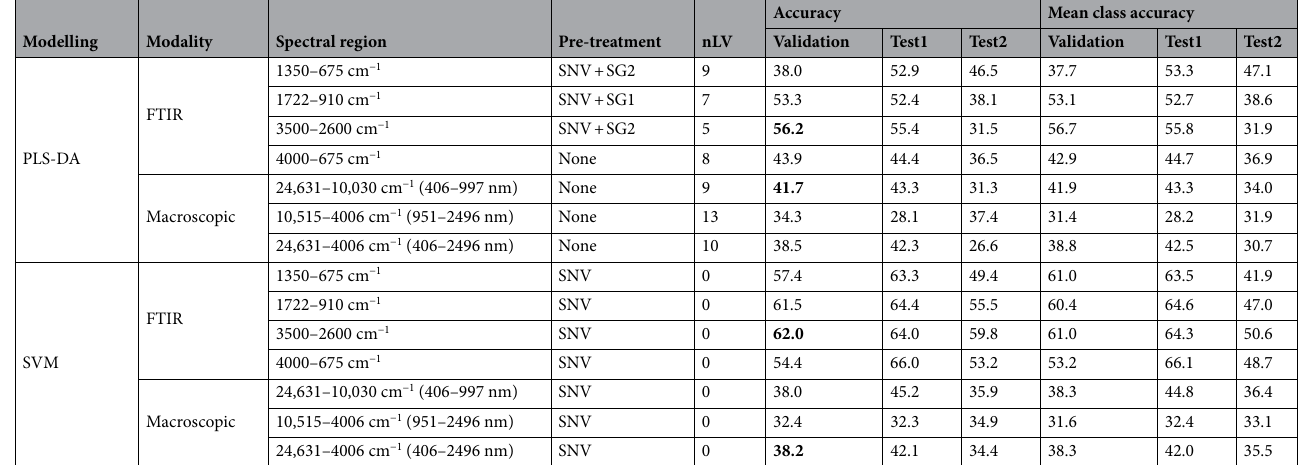
Table 7. Model performances for discrimination between GN species EC, CS and PF based on pixel spectra. For each modality/spectral region, the model yielding maximum accuracy in the validation set is